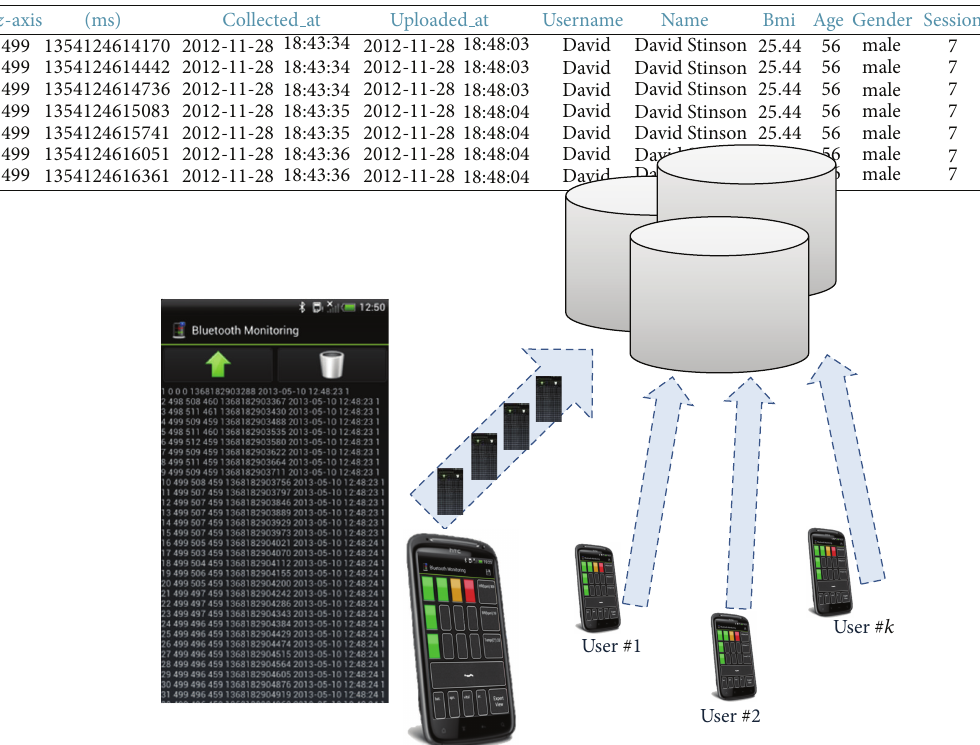
Figure 5: The PhysioDroid app may be used as a gateway to upload the monitored data to a remote persistent storage unit. This action may be performed either manually or by setting up a routine for the upload